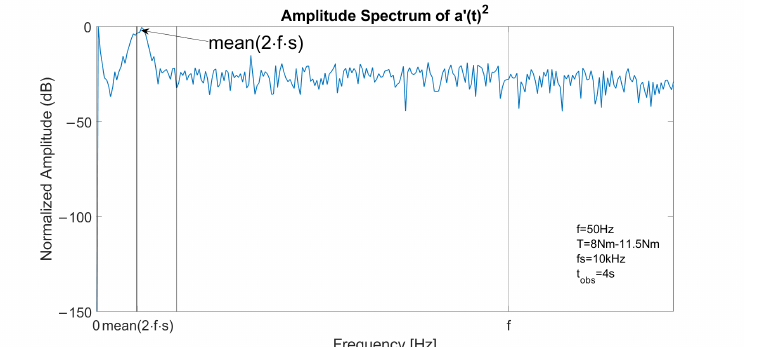
Figure 8. Spectrum of the square of the analytical signal a (cid:48) ( t ) 2 of a stator current in case of one broken bar and linear ramp of requested torque from 8 Nm to 11.5 Nm (increasing slip). The main component is located at the mean value of 2 sf